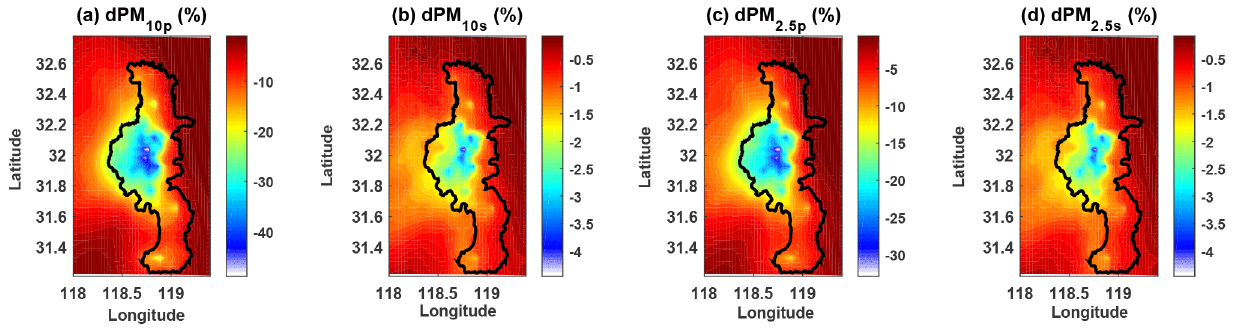
Figure 11. Influence of emission reduction on hourly mean concentrations of primary and secondary particulate matter in Au- gust 2014. Black thick lines draw the outline of Nanjing. Panels (a–d) are hourly average values of impact percentage (dspecies (%) = (Experiment 1 − Experiment 2) / Experiment 2 × 100%) of PM 10p , PM 10s , PM 2 . 5p and PM 2 . 5s .